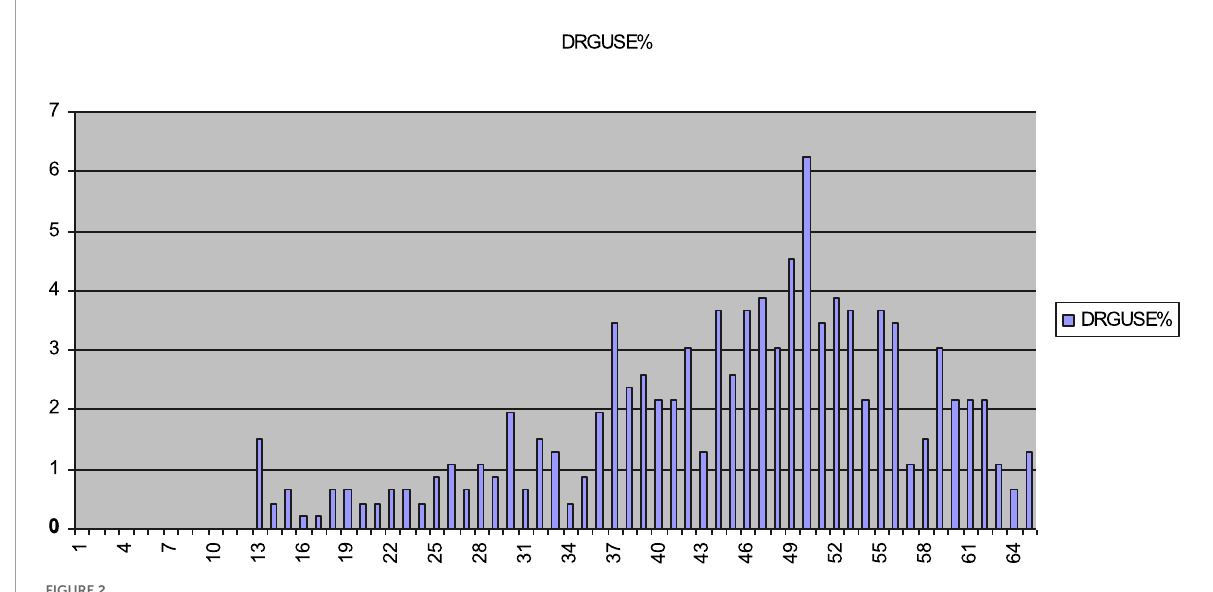
FIGURE2 Percentage of endorsement for total scores for DUPS. Total scores for DUPS approach a normal distribution. DUPS is the drug use problems scale.